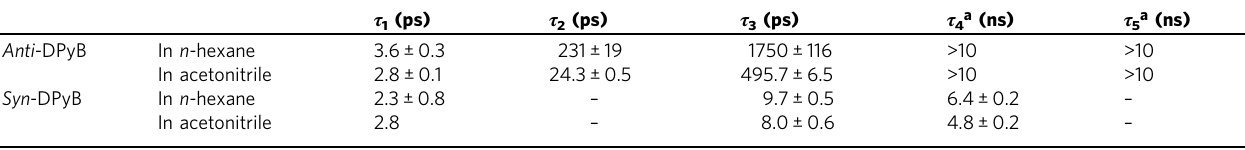
Table 2 Time constants determined from TA measurements for Anti -DPyB and Syn -DPyB in n -hexane and acetonitrile a